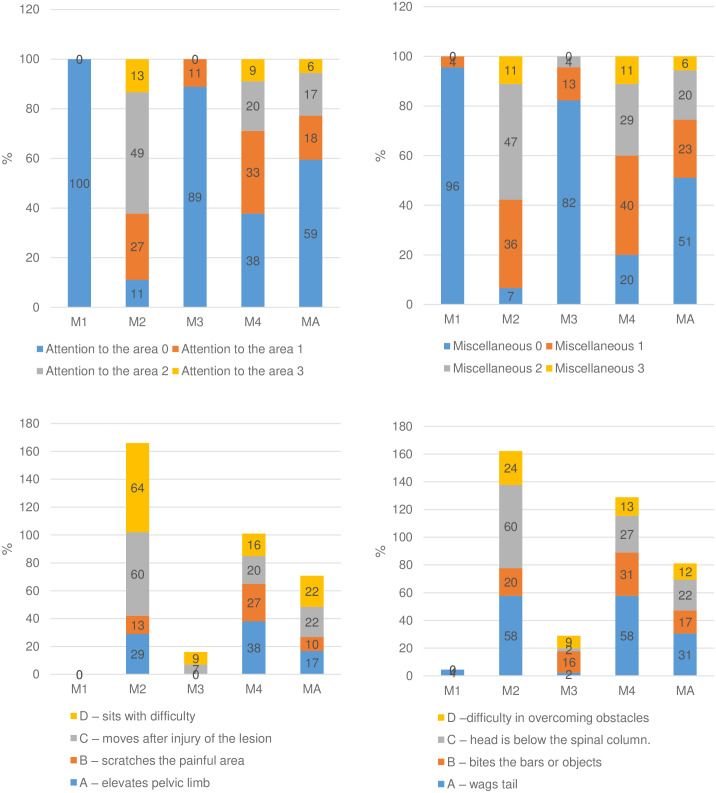
Frequency of the presence of scores of each item of the UPAPS.Legend: sum of the scores (top left) and individual scores (bottom left) of attention to the affected area and sum of the scores (top right) and individual scores (bottom right) of miscellaneous behaviours.